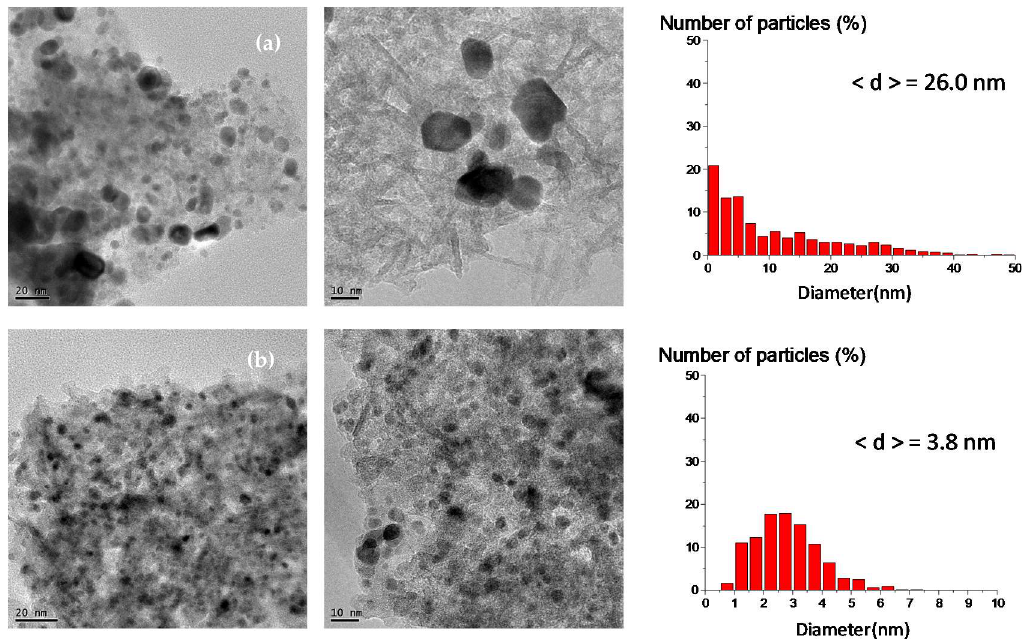
Figure 1. TEM pictures and size distribution of bimetallic catalysts: ( a ) SI–(Pt–Ru)/S40, ( b ) CR–(1%Ru–Pt)/S40. (TEM pictures representative of other bimetallic catalysts are available for consultation in Reference [25]).